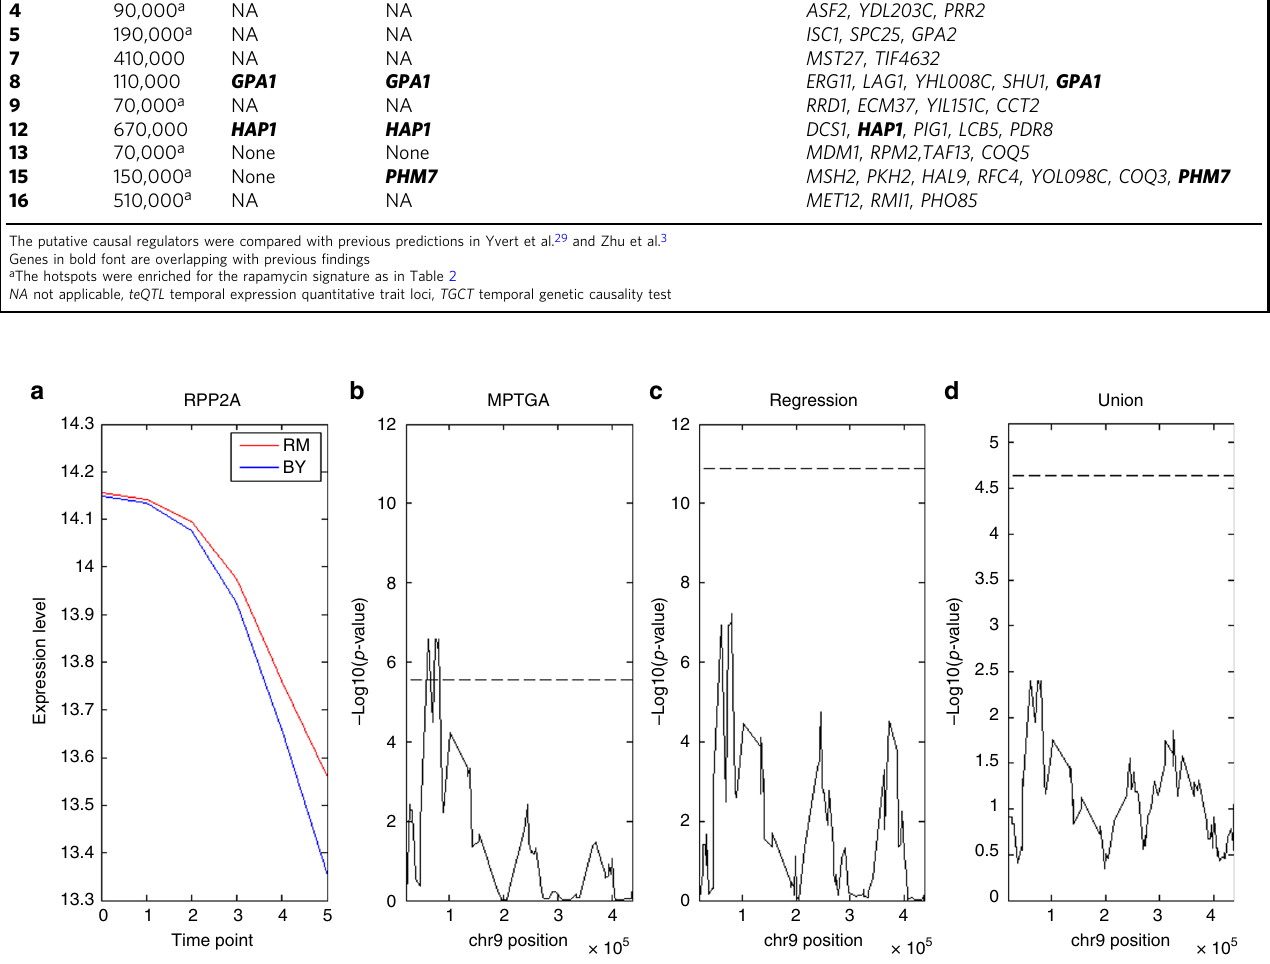
Fig. 4 The teQTL hotspot chrIX:70,000 was only identi fi ed by the MPTGA method. a A typical pattern of expression traits linked to the teQTL hotspot. b Plot of – log 10( p -value) of RPP2A association at chrIX based on the MPTGA method. c Plot of – log 10( p -value) of RPP2A association at chrIX based on the regression method. d Plot of – log 10( p -value) of RPP2A association at chrIX based on the union method. Dashed lines in ( b , c ), and d are the p -value cutoff corresponding to FDR =